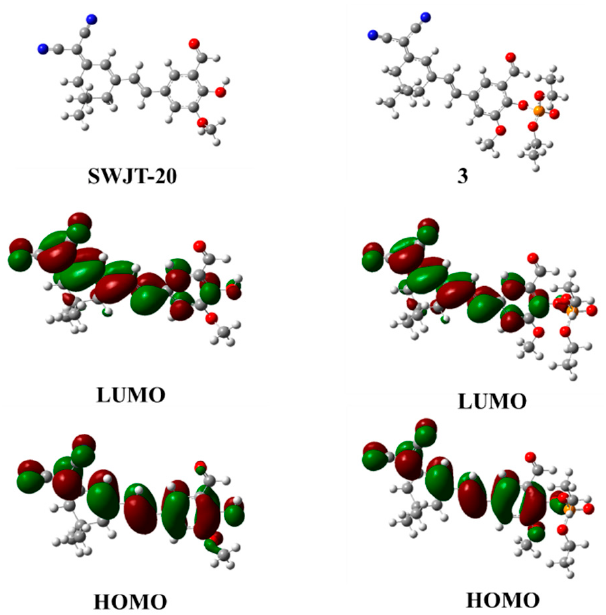
Figure 4. Optimal structure and frontier molecular orbital energy level plots of SWJT-20 and compound 3 .